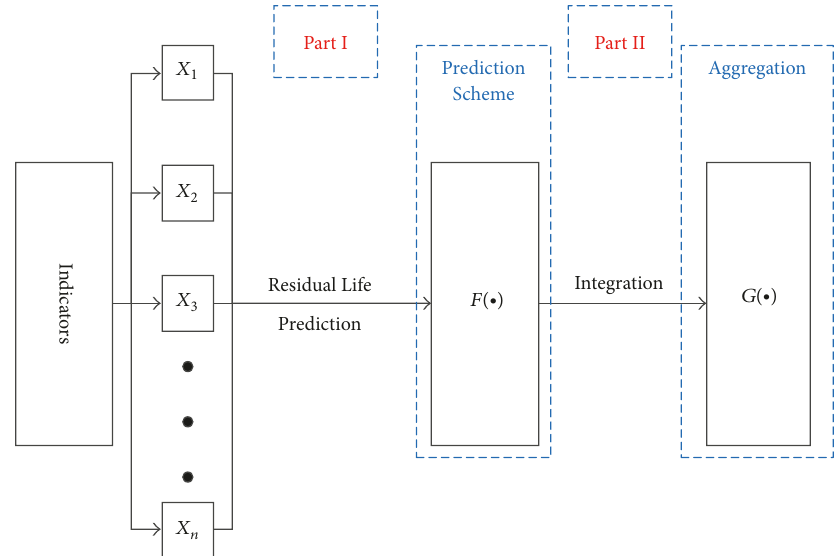
Figure 1: Main structure of the new residual life prediction